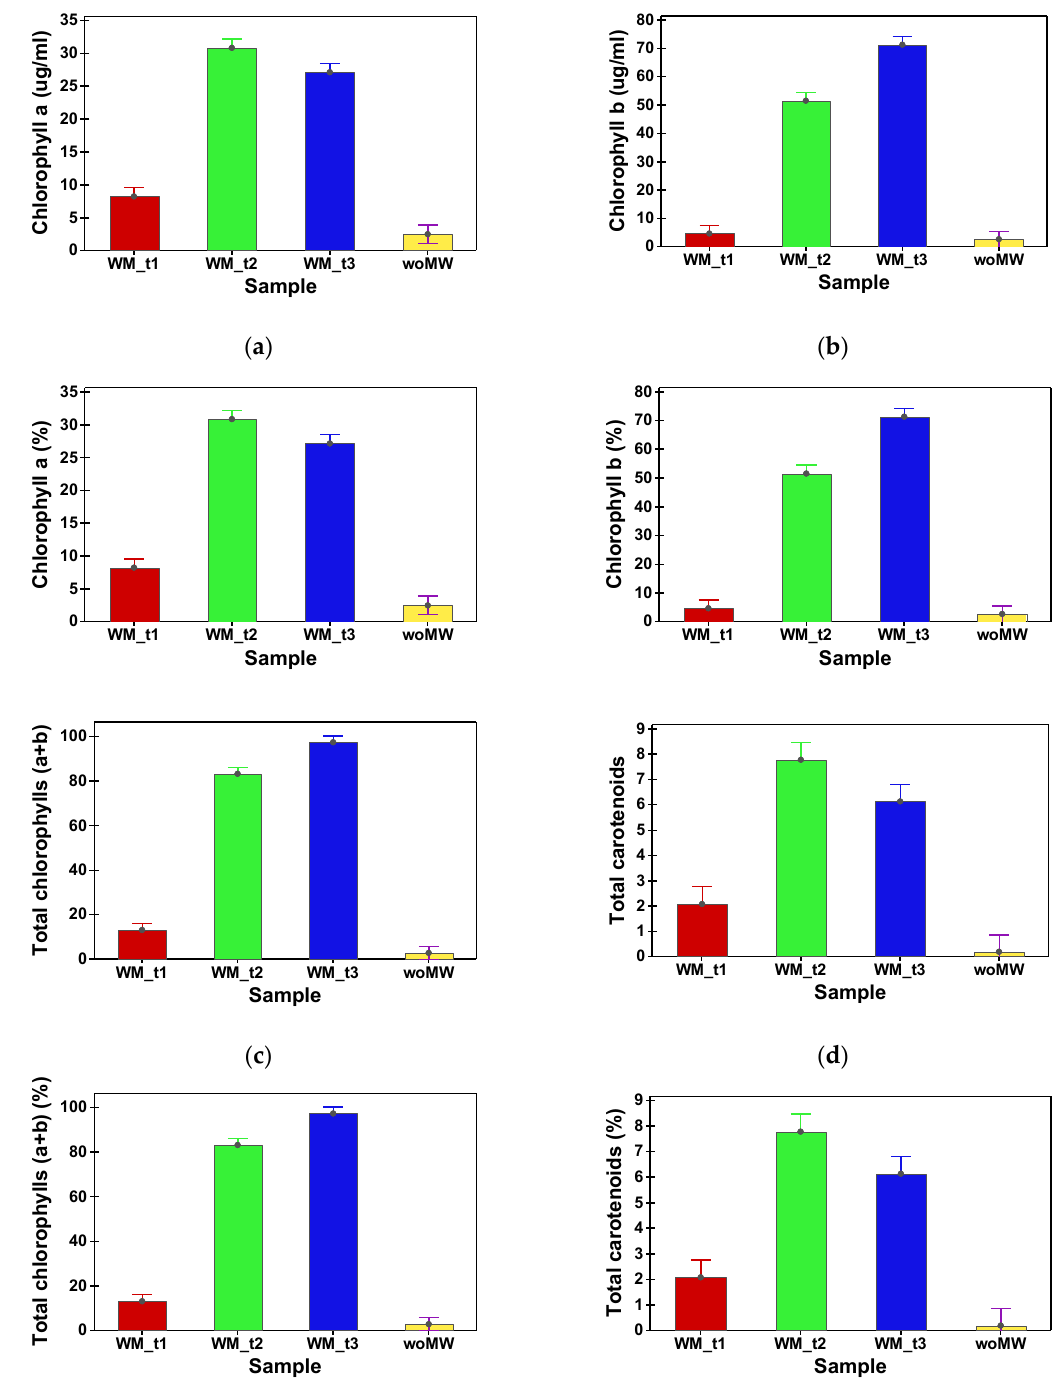
Figure 5. Ratios (%) between MW samples (MW_t1, MW_t2, and MW_t3) and the untreated sample, woMW. Chlorophyll a ( a ), chlorophyll b ( b ), total chlorophyll ( c ), and total carotenoids ( d ) .